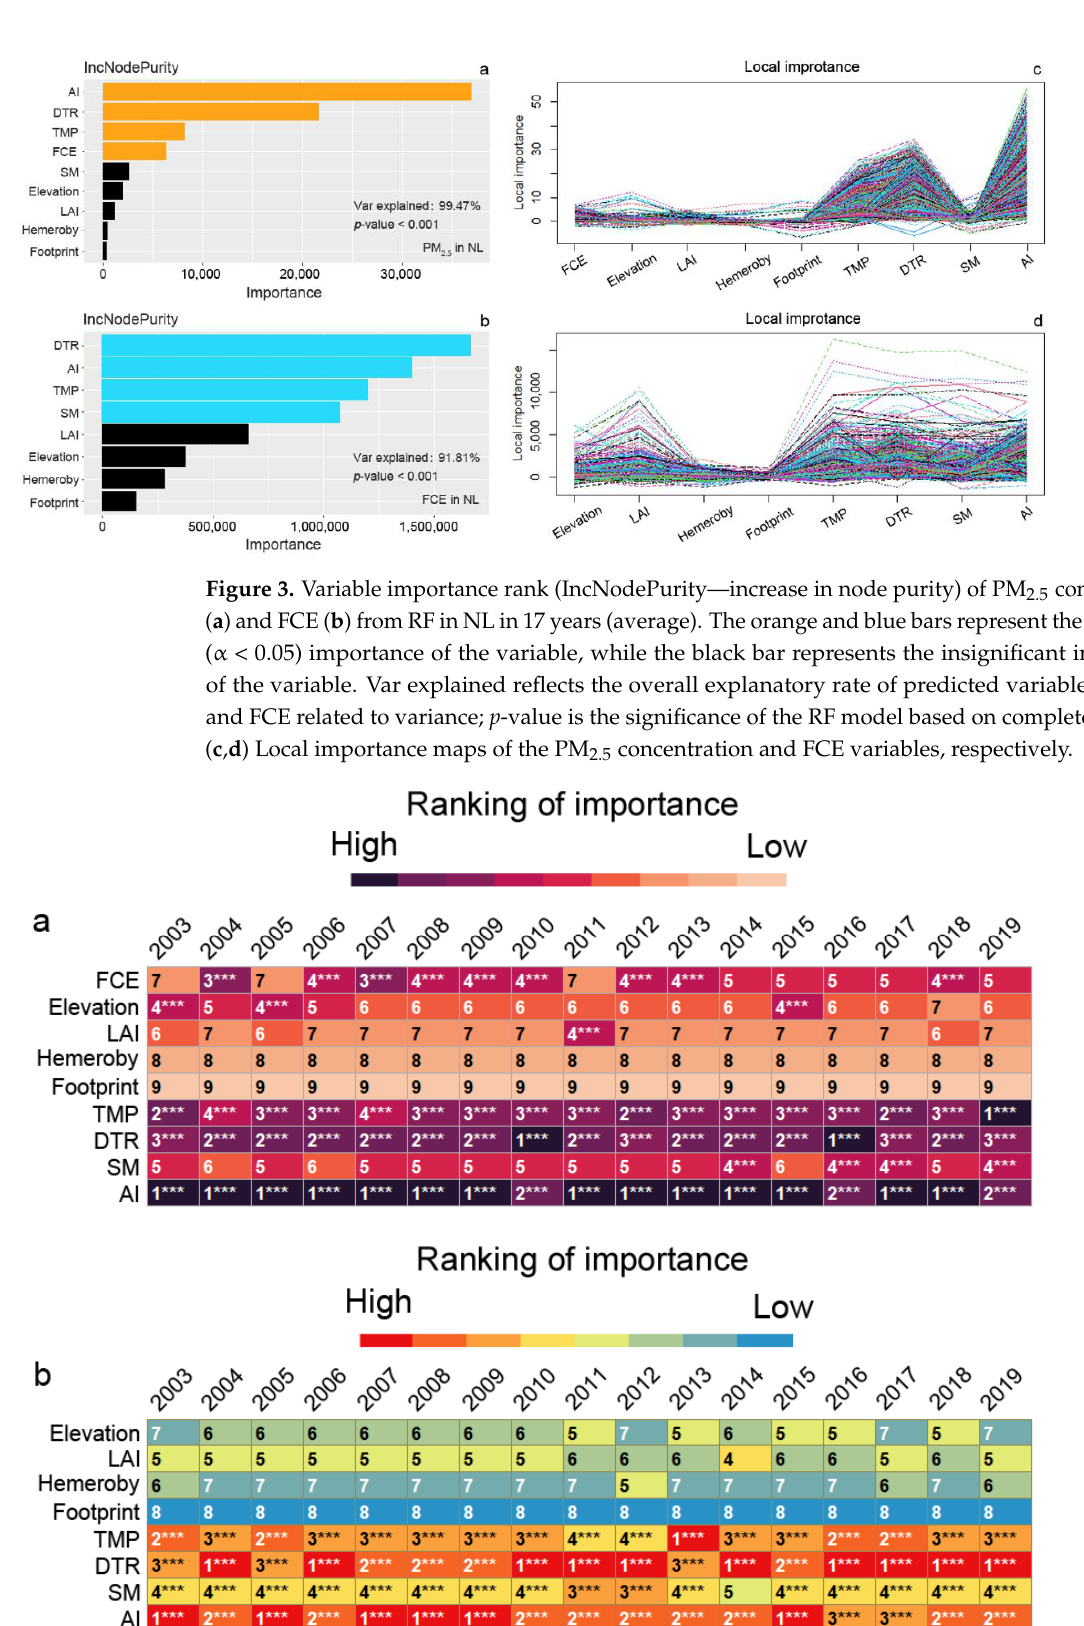
Figure 4. The effect of annual variables by RF on PM 2.5 concentration and FCE in NL. ( a , b ) Ranking of importance of variables affecting PM 2.5 concentrations and FCE in NL, respectively. “***” represents significant at 1% level, that is, p < 0.01